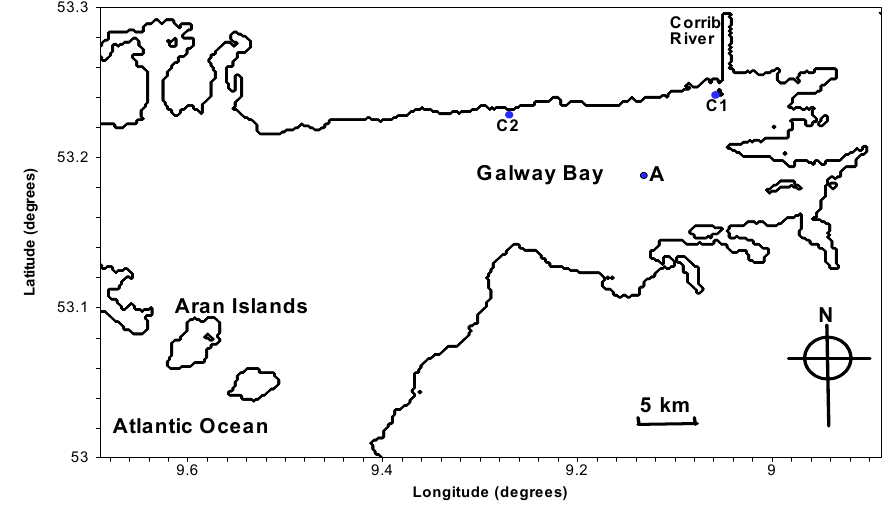
Figure 1. Deployment of HF radar system in Galway Bay (C1 indicates the HF radar on Mutton Island; C2 indicates the HF radar located near Spiddal; A indicates a reference point for analysis).